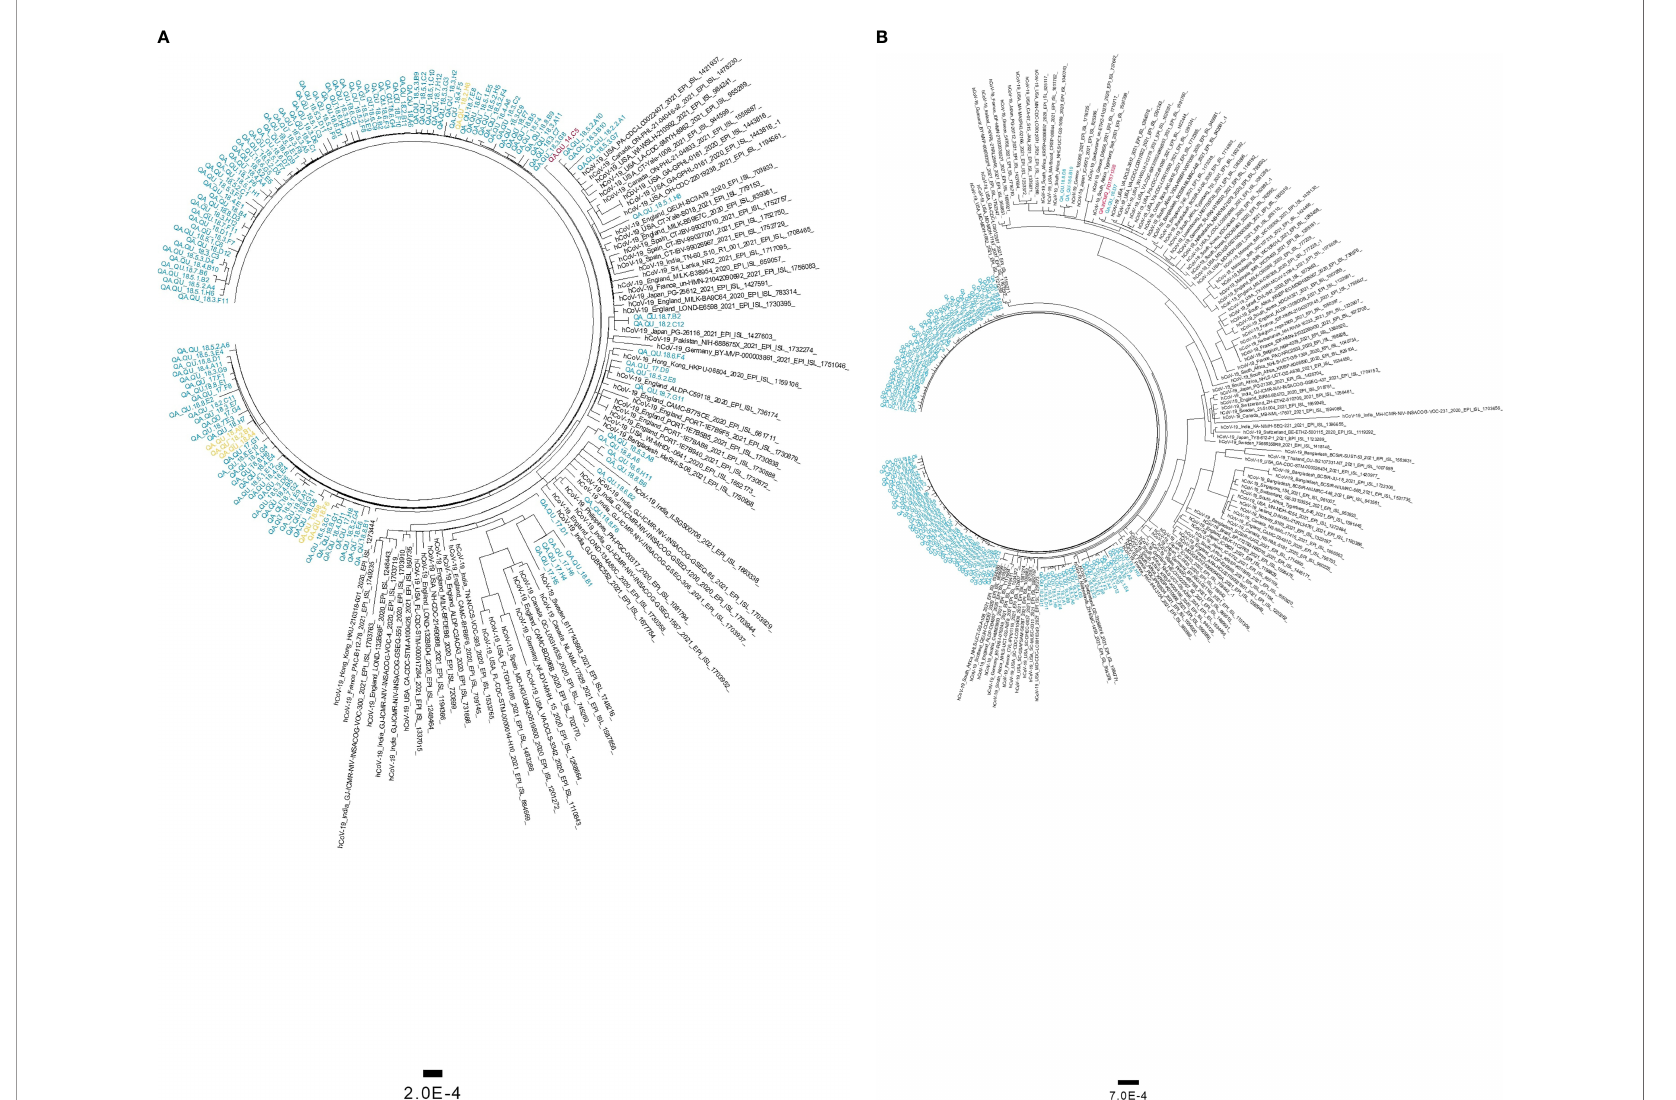
FIGURE 5 | Maximum likelihood trees of SARS-CoV-2 variants of concern detected in this cohort. Phylogenetic tree of B.1.1.7 genomes (A) and B.1.351 genomes (B) were generated using 134 and 112 local sequences, respectively. Global genomes representative of the two clades with collection dates from November 2020 to March 2021 were included in the phylogenetic tress. Global genomes are indicated in black, local genomes are colored in blue, and imported samples are colored in yellow. The fi rst genome detected locally is colored in